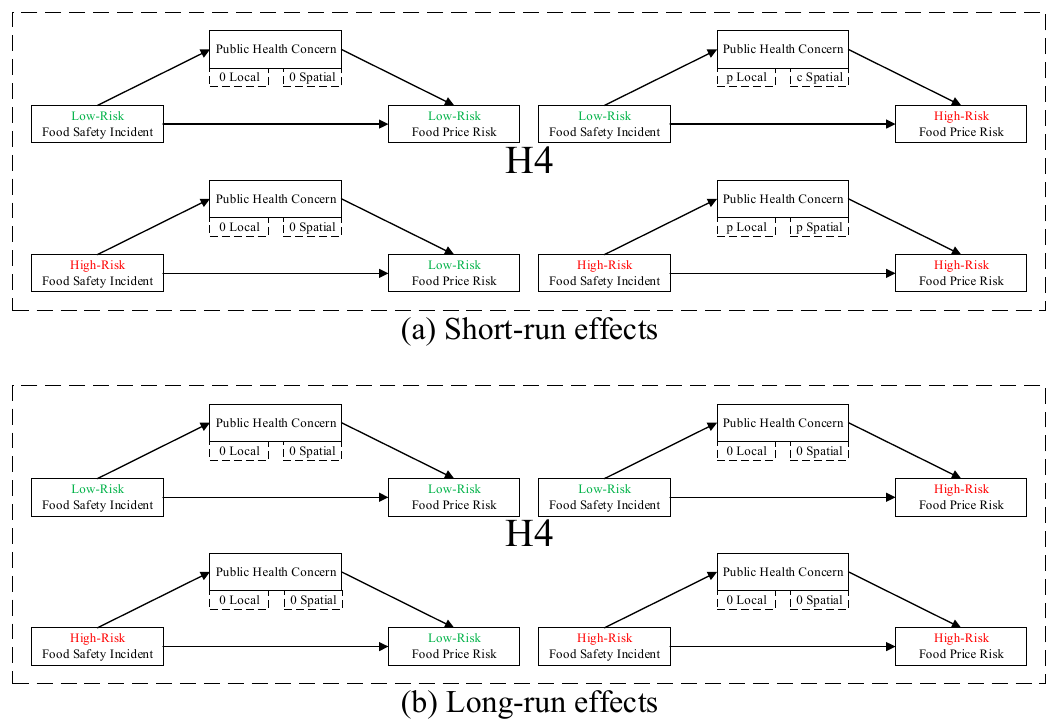
Figure 8. Test results for hypothesis H4. The symbols “0”, “p”, and “c” show “insignificant”, “partial”, and “complete” mediation, respectively. Source: Originally developed by the authors.